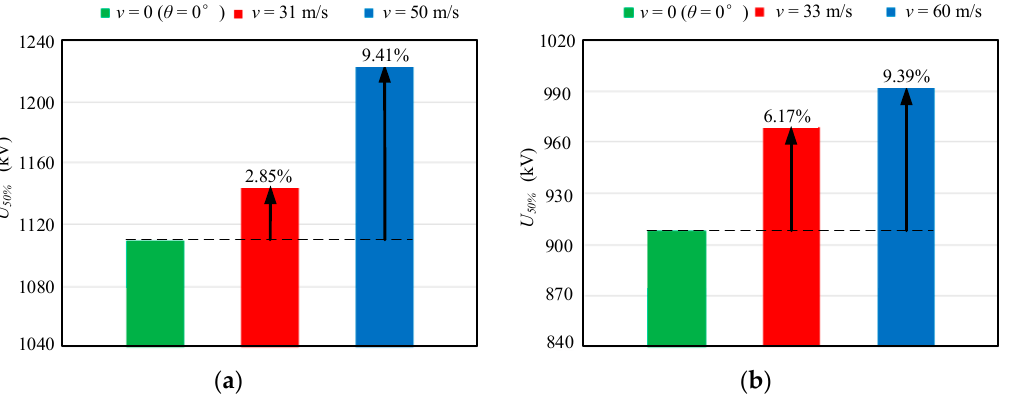
Figure 9. Relationship between U 50% and v in 2 m air gap. ( a ) test results in [13]; ( b ) test results in the present paper; v = 0 ( θ = 0°): one blade is straight up.